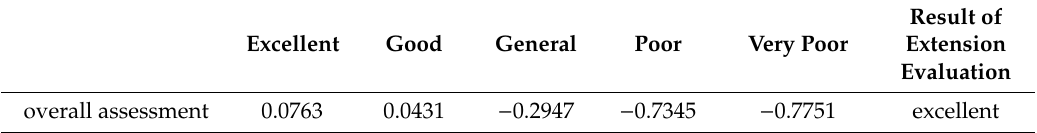
Table 9. Evaluation result of information quality on power